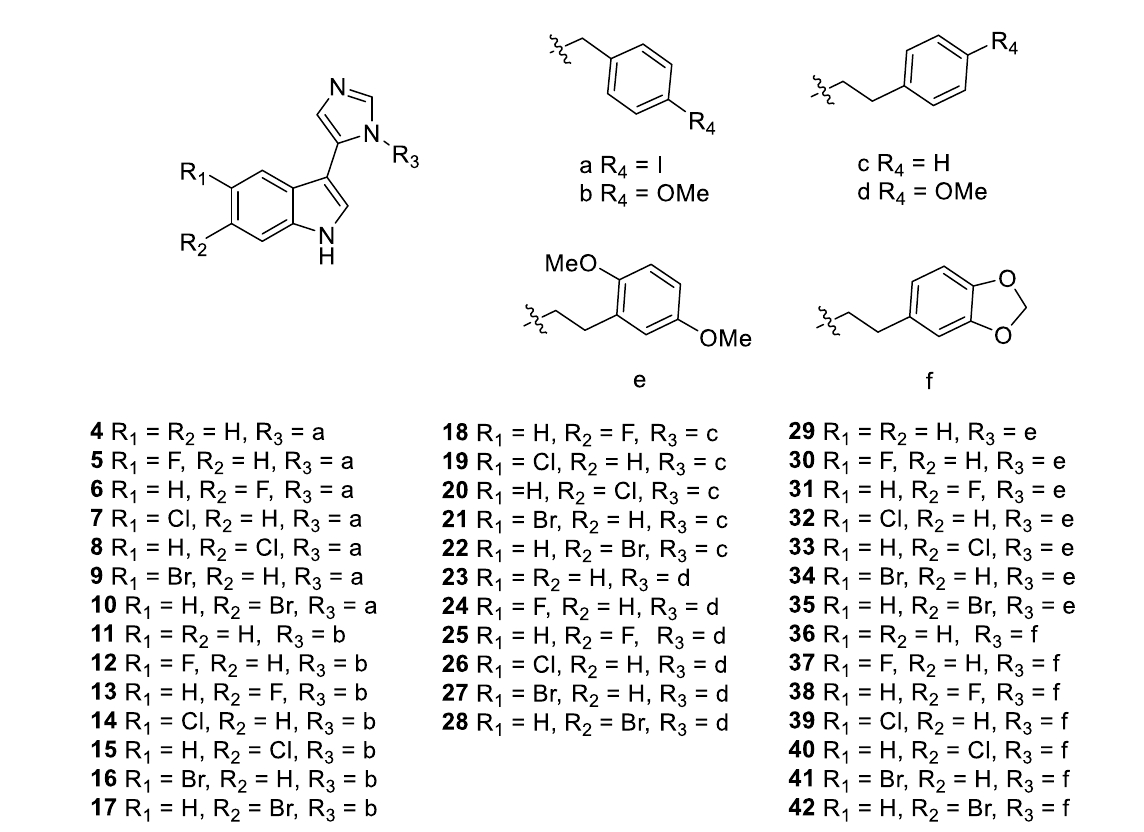
Figure 2. Structures of substituted indole-imidazoles 4 – 42 .